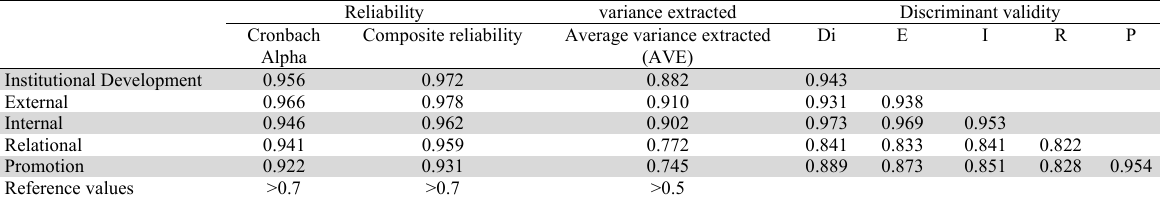
Confirmation of model according to dimensions Reliability variance extracted Discriminant validity Cronbach Composite reliability Average variance extracted Alpha